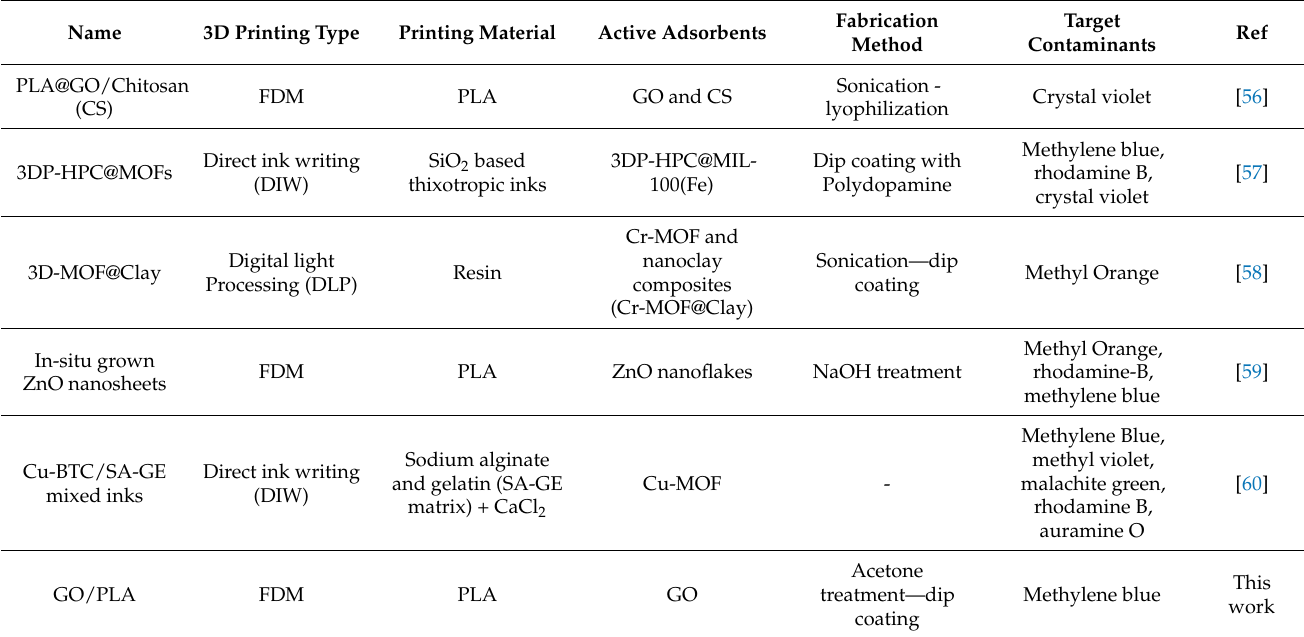
Table 3. List of 3D-printed adsorption filters for dye adsorption.